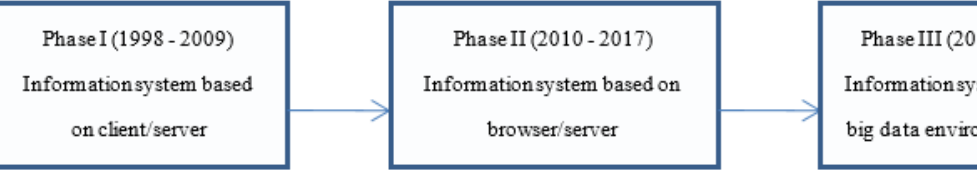
Phase I took place from 1998 to 2009, when local MIISs were established separately in different pooling-based regions in China according to the needs for business development.